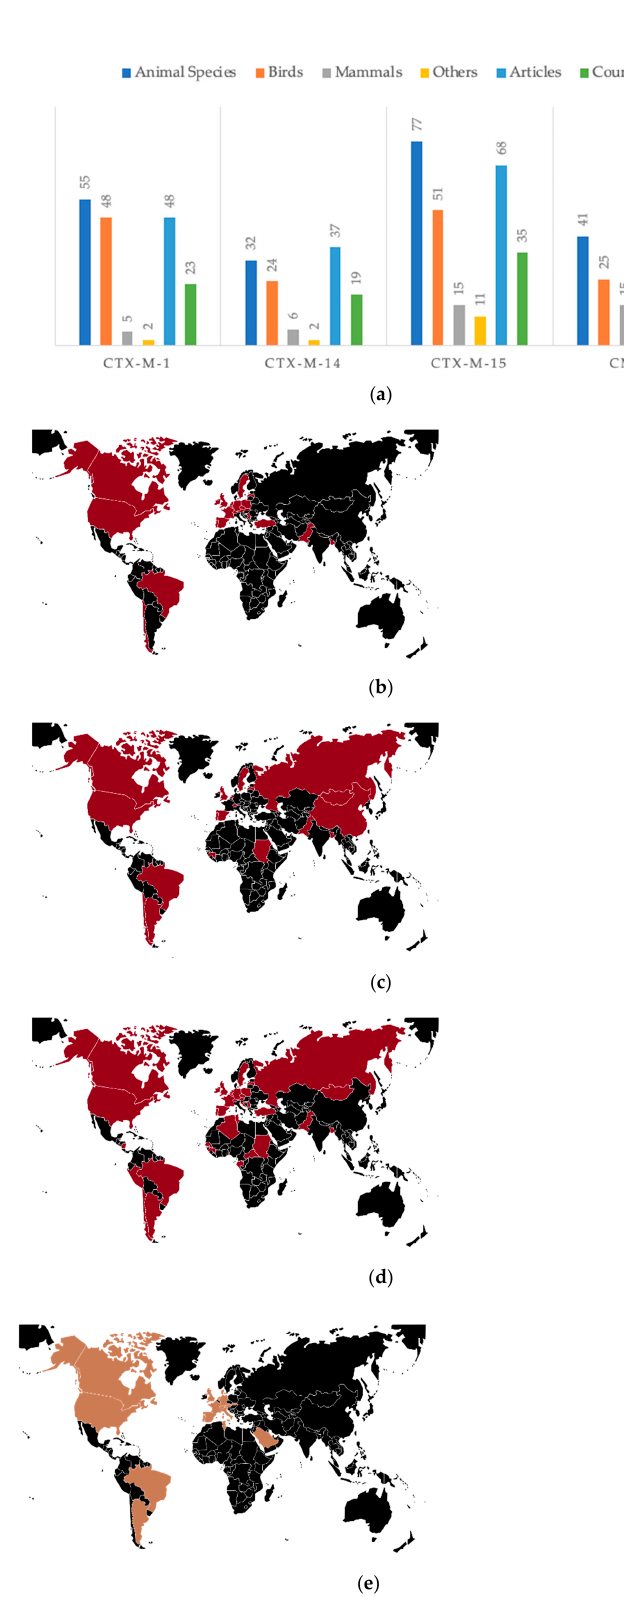
Figure 7. Summarizing data for the top 4 cephalosporinases reported in wildlife, including ( a ) animal species and taxa, publications and country numbers, and also the worldwide distribution of ( b ) CTX-M-1, ( c ) CTX-M-14, ( d ) CTX-M-15 (burgundy, ESBL beta-lactamases), and ( e ) CMY-2 (light brown, AmpC beta-lactamase) (others include fish, reptile, and invertebrate).